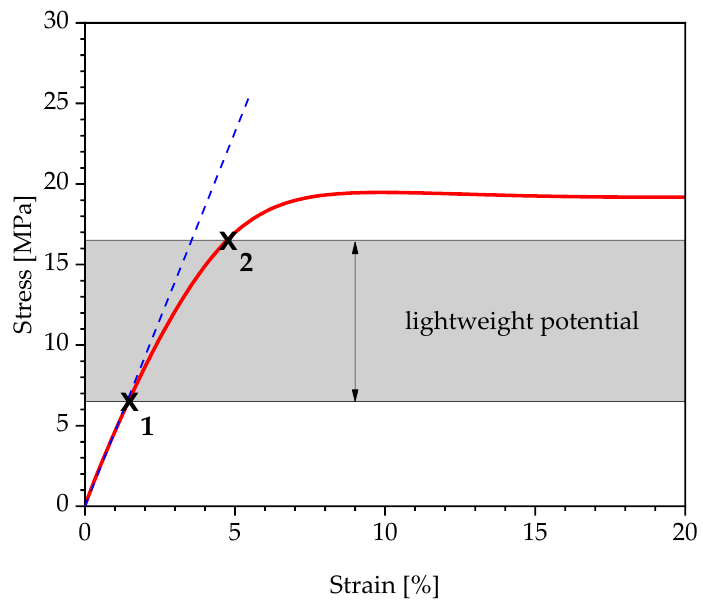
Figure 1. Schematic illustration of the utilisation of lightweight construction potential by considering reversible nonlinear viscoelastic deformation components.